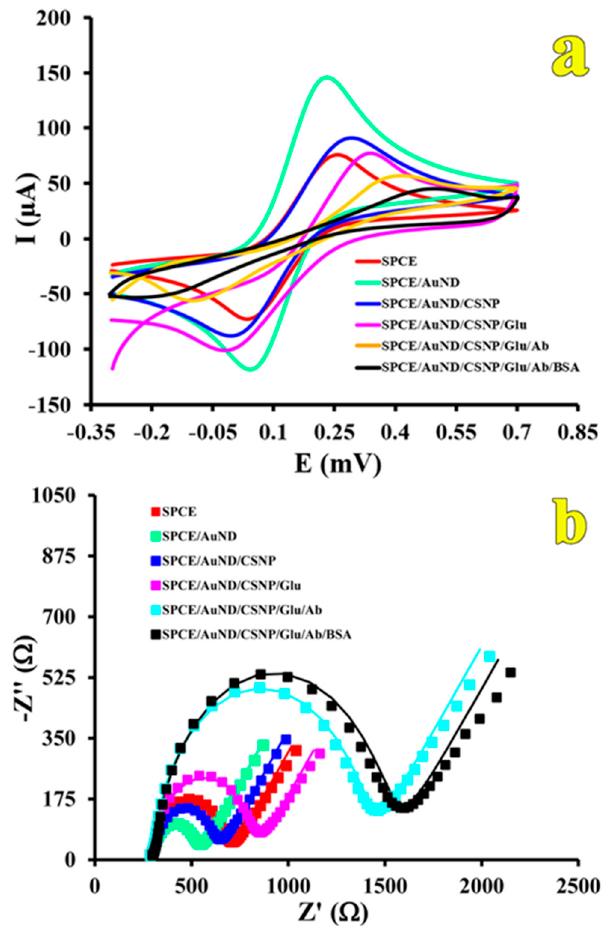
Figure 2. ( a ) CV and ( b ) EIS responses for step by step fabrication of proposed immunosensor. Measurements were performed in PBS (0.1 M and pH= 7.4), containing 5 mM of [Fe(CN) 6 ] 3 − /4 − and 0.1 M KCl.